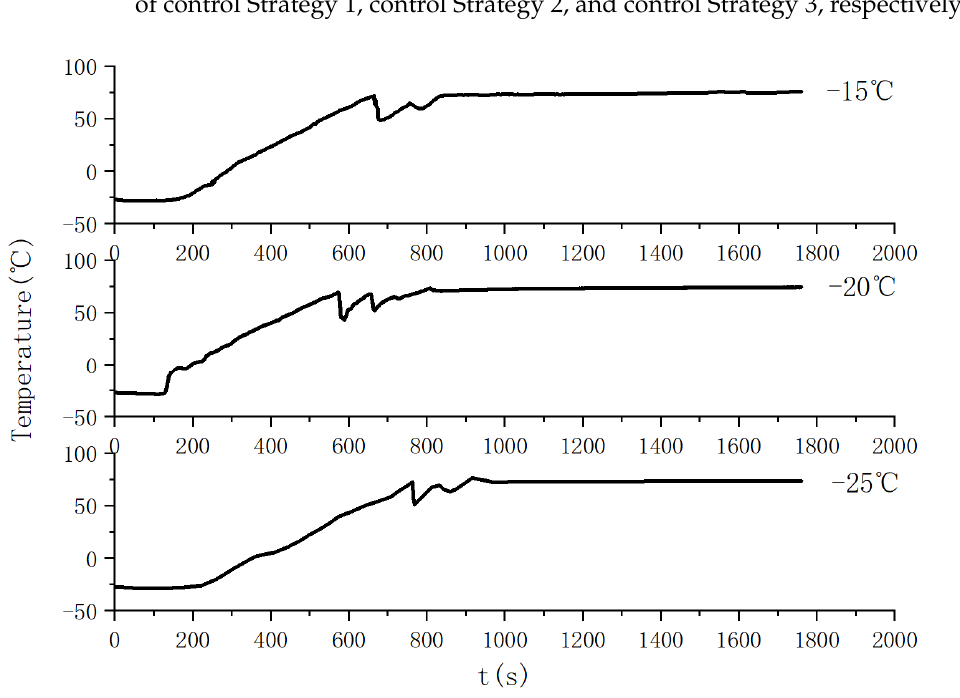
Figure 3. Graph of the temperature change in Stack Bwith time.